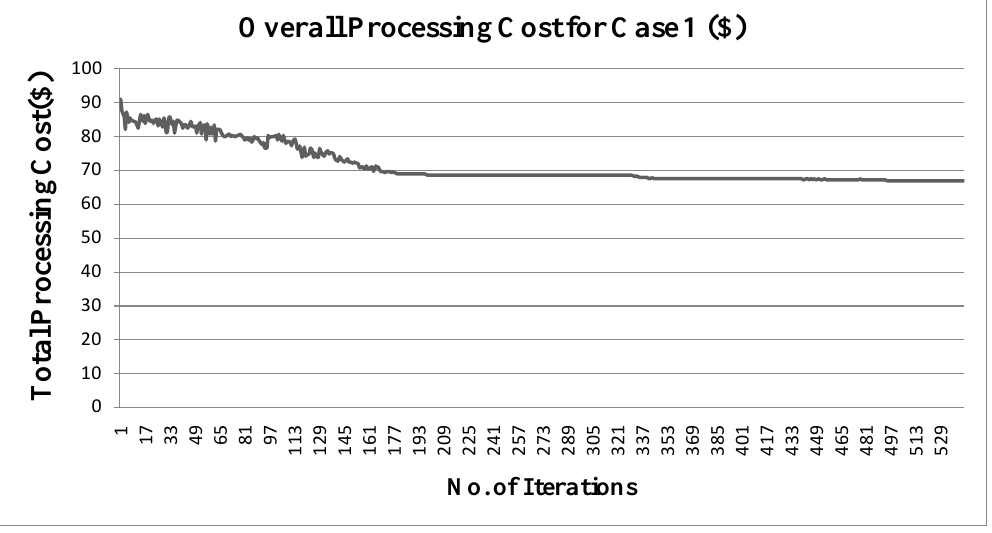
Fig. 3.a. Convergence of overall processing costs ($) of Case 1 using PSO Case 2: The following algorithm specific parameters for particle swarm optimization are obtained through various computational experiments.